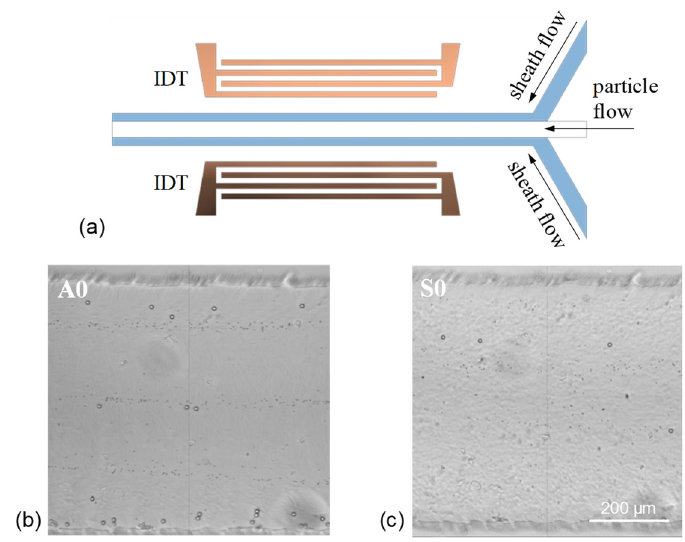
Figure 10. ( a ) Device layout and channel configuration with the main channel width w = 600 μ m for acoustic separation. Experimental results of particle separation by using the standing Lamb waves of ( b ) the A0 mode and ( c ) S0 mode. The total volume flow rate is 5 μ L/min, and the used RF power is 32 dBm.